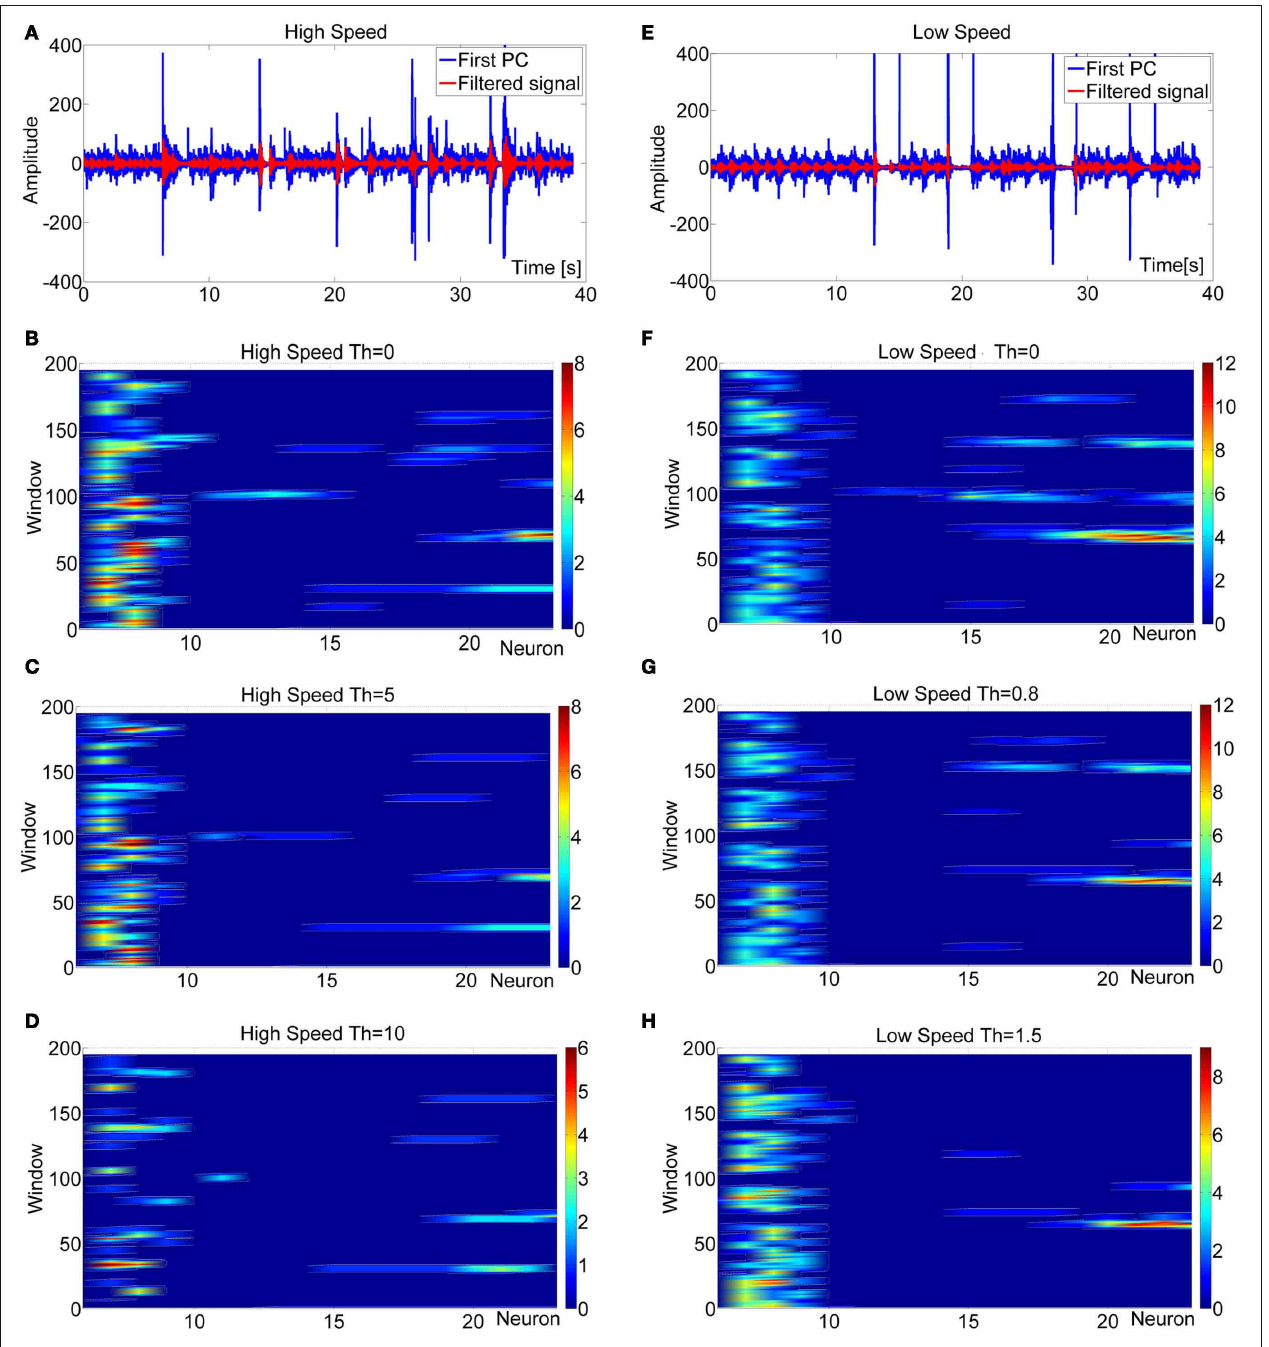
(window 170). The maps show the responses of the sensory array of resonate neurons (columns of the maps), by color-coding their spike rate, in time. Rows correspond to time windows of 1s duration, with a sliding time of 200ms used between two consecutive windows. With a threshold Th = 0, some artifacts appeared as in (B) and (F) that do not correspond to real contact events. For high values of Th , real contact events could disappear from the map (D) – (H) . Finally, for optimal values of Th , contact events were detected correctly (C) – (G) . Note that the optimal value of Th depended on the speed of the